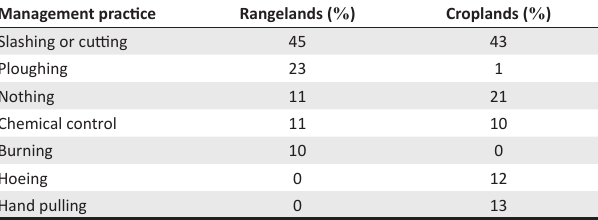
TABLE 3: The percentage of respondents ( n = 166) who used particular management practices to control Tithonia diversifolia in rangelands and croplands in the Copperbelt Region, Zambia.